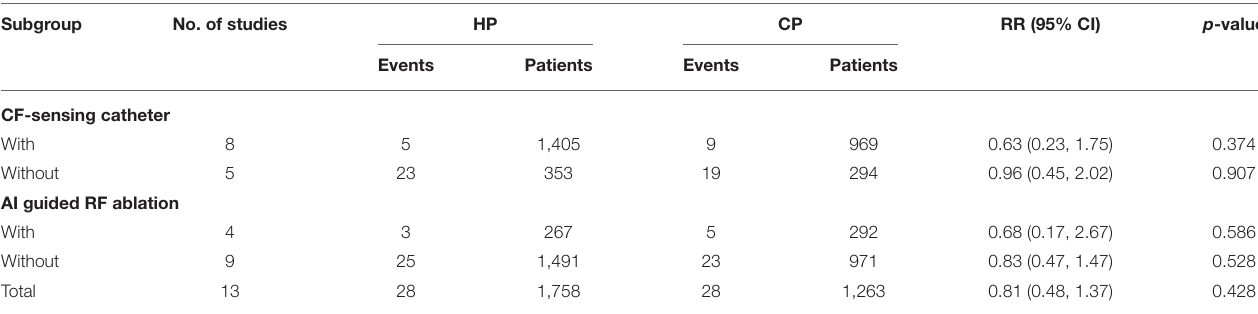
TABLE 6 | Subgroup analysis of procedure-related